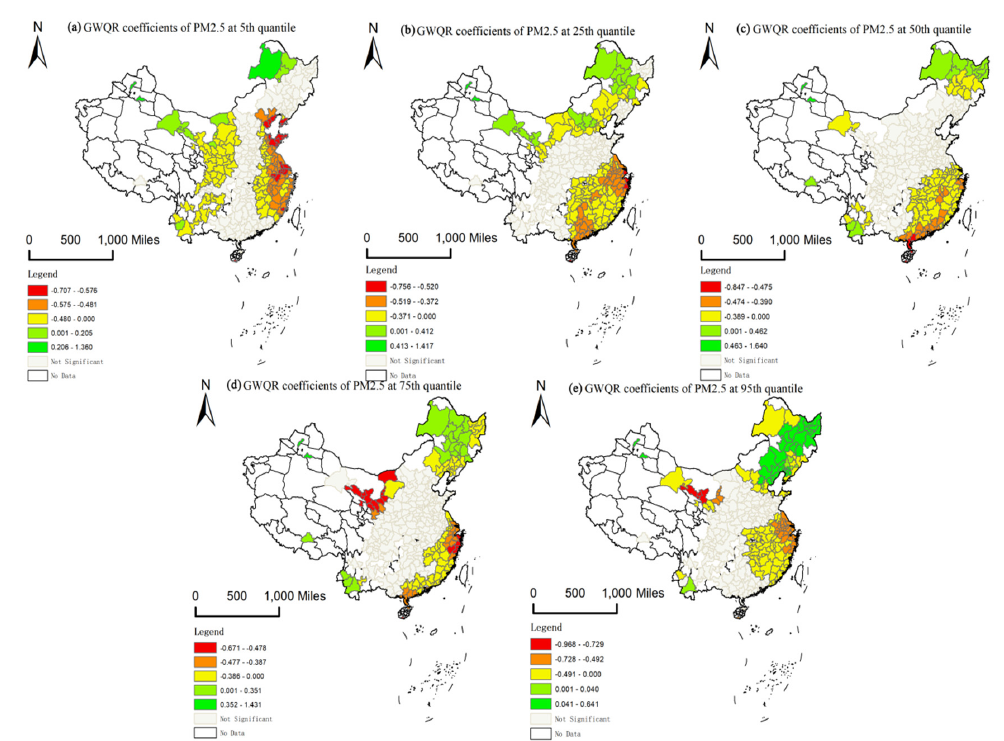
Figure A3. Spatial visualization of significant PM2.5 coe ffi cients of GWQR (exponential kernel function) for 2013. ( a – e ) represent the spatial distribution of significant PM2.5 coe ffi cients for the 5th, 25th, 50th, 75th, and 95th quantiles respectively.